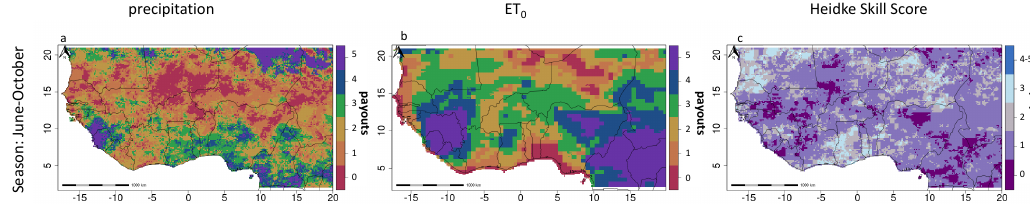
Figure 7. ( a ) Seasonal payouts that occurred during 1999–2016 in the precipitation dataset. ( b ) Seasonal payouts that occurred during 1999–2016 in the ET 0 dataset. ( c ) Heidke Skill Score for the payouts of ET 0 to the precipitation payouts. This plot shows where the precipitation data and the ET 0 data have between 0 and 5 payouts occurring in the same year.